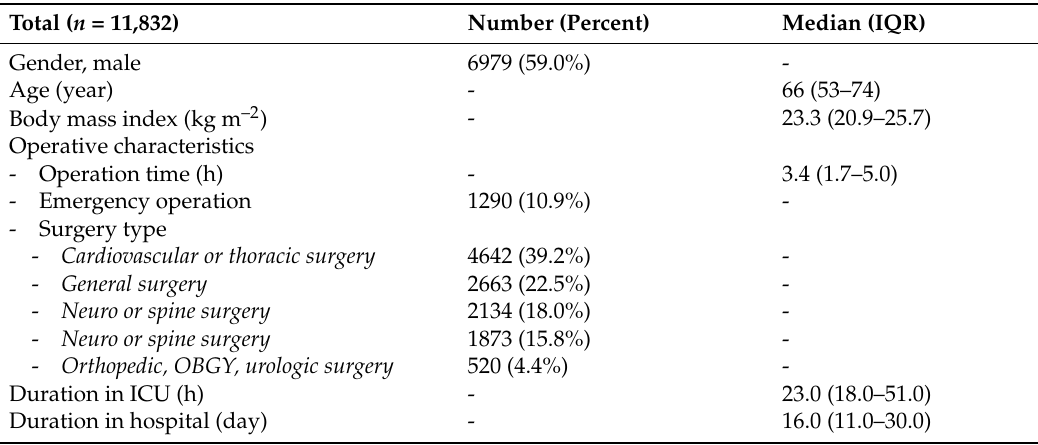
Figure 1. Patients’ flow chart. CRP: C-reactive protein; ALB: albumin. Table 1. Baseline characteristics of